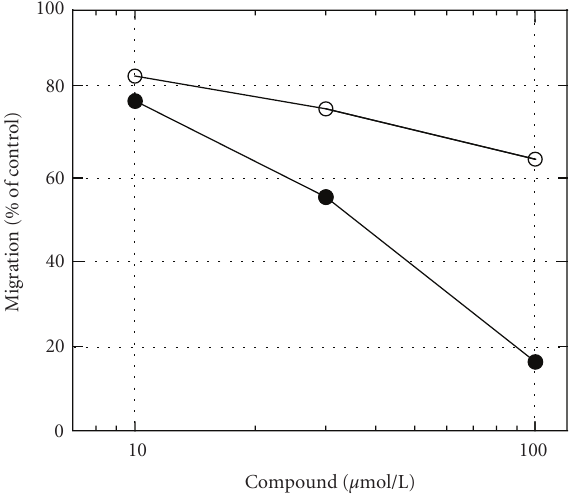
Figure 2: Comparison of the abilities of olopatadine (open circle) and amlexanox (closed circle) to inhibit THP-1 migration induced by S100A12. Migration assay was performed as described for the prior experiments. Values are percentages of control, and are the means of 2 independent